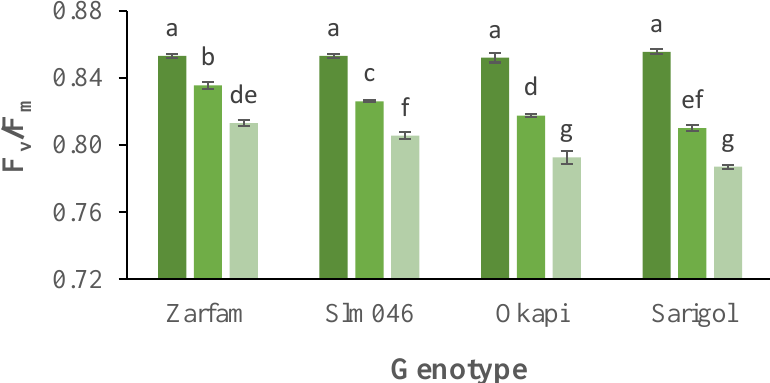
Figure 3. Interaction effect of drought stress and genotype on the maximum quantum yield ( F v /F m ) of canola leaves. Data are means ( n = 3) ± SE. Different letters indicate differences ( p < 0.05) among treatments according to the Duncan test.